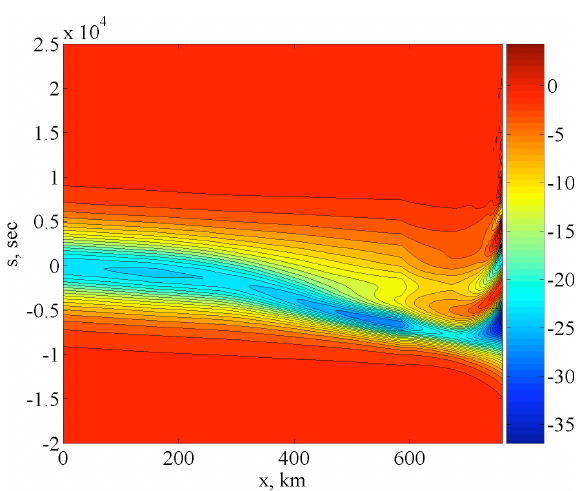
Fig. 17. Transformation of an internal solitary wave along cross- section 2, initial amplitude